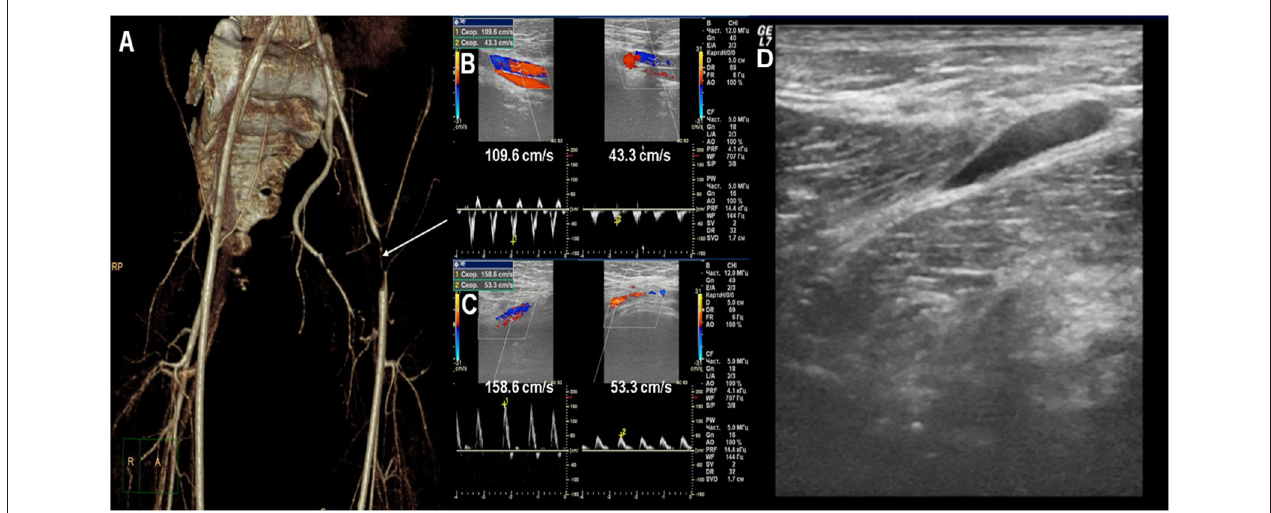
FIGURE 2 | The rash in Twin 1 during the flare (Month 30 from the onset).